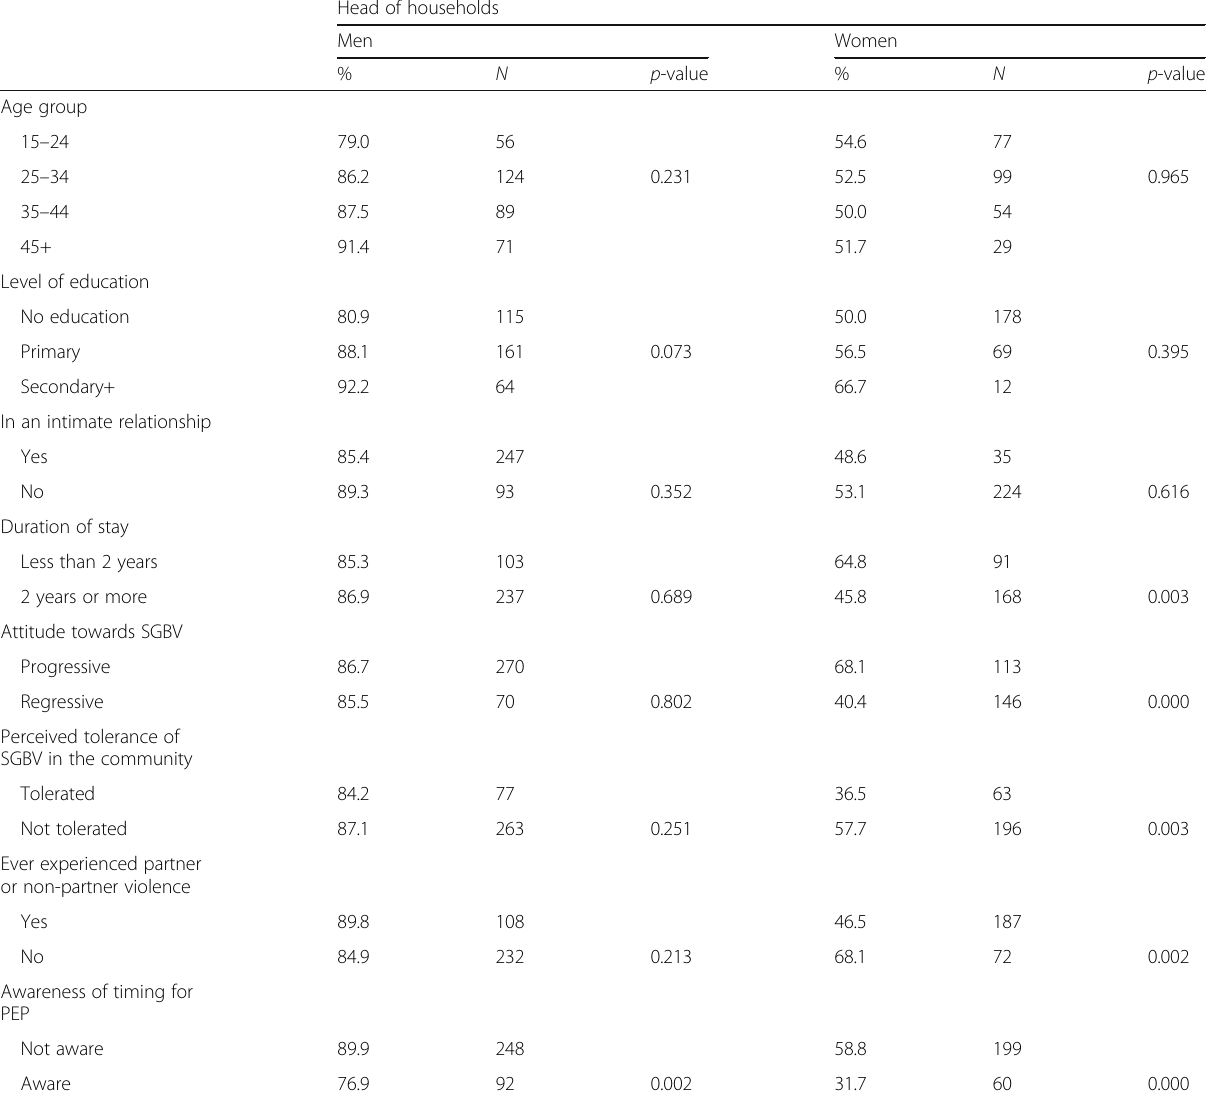
Table 3 Proportion of respondents with favorable attitude towards help-seeking for SGBV by background characteristics Head of